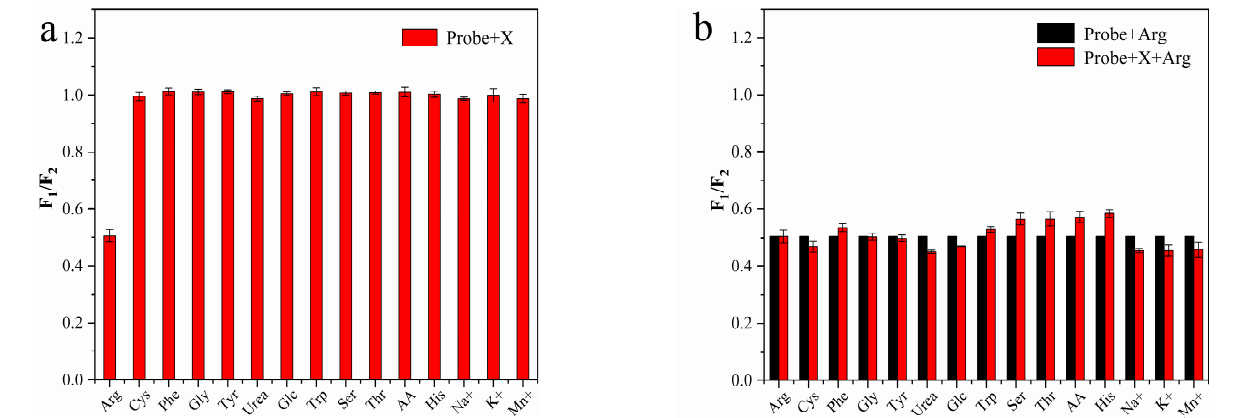
Figure 12. ( a ) F 1 /F 2 ratio of N-CD/calcein sensor on Arg and other substances’ detection; ( b ) F 1 /F 2